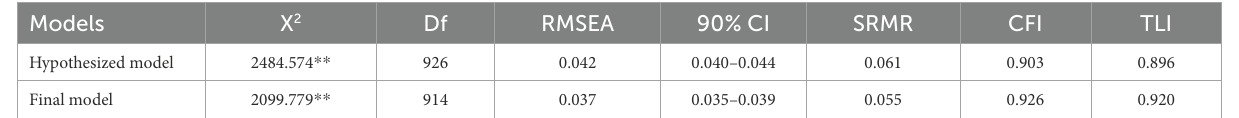
TABLE 4 Fit indices of the predictive model of career satisfaction and dropout intention.